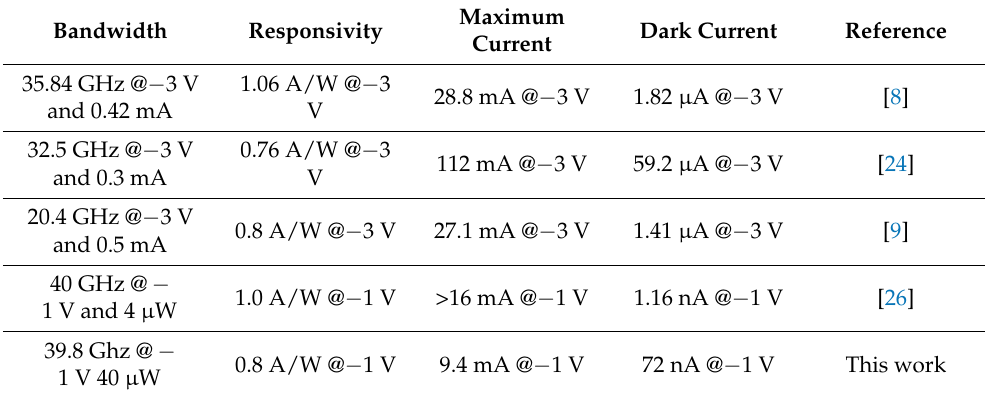
Table 2. Comparison of the high-power Ge PDs in the literature and our